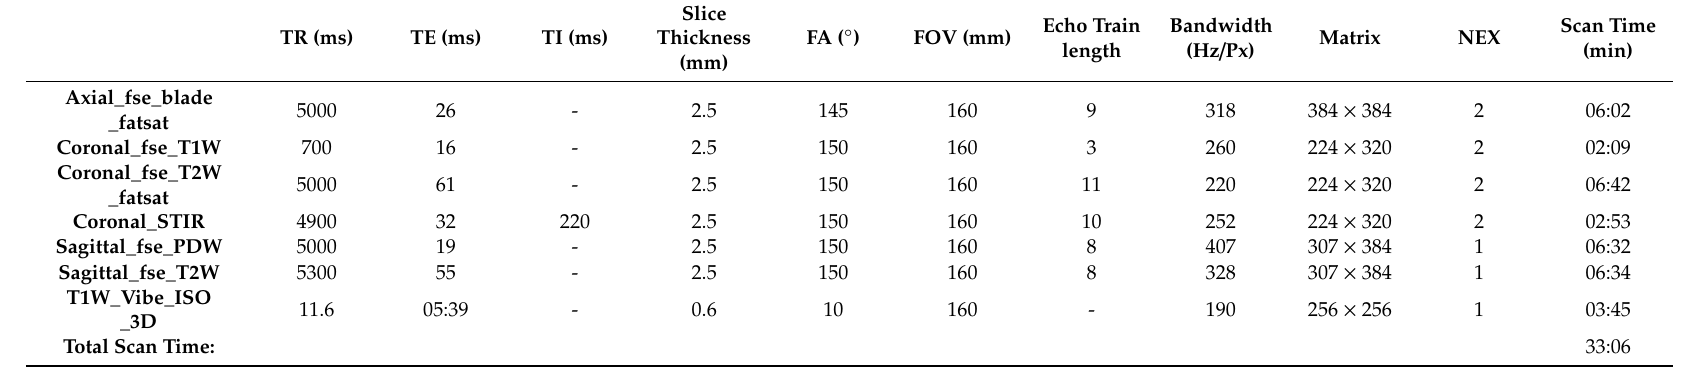
Table 2. Magnetic resonance sequences used. Repetition time (TR); echo time (TE); inversion time (TI); flip angle (FA); field of view (FOV); pixel (Px); number of excitations